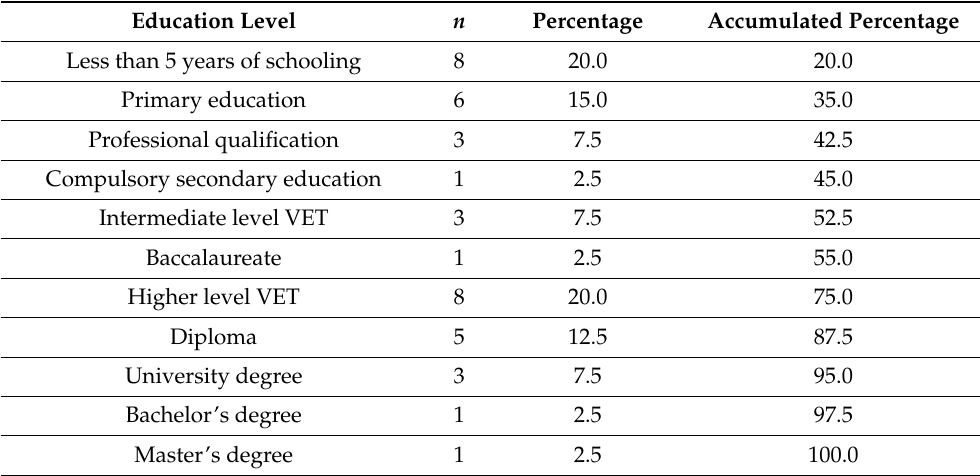
Table 1. Distribution of the sample according to education level.